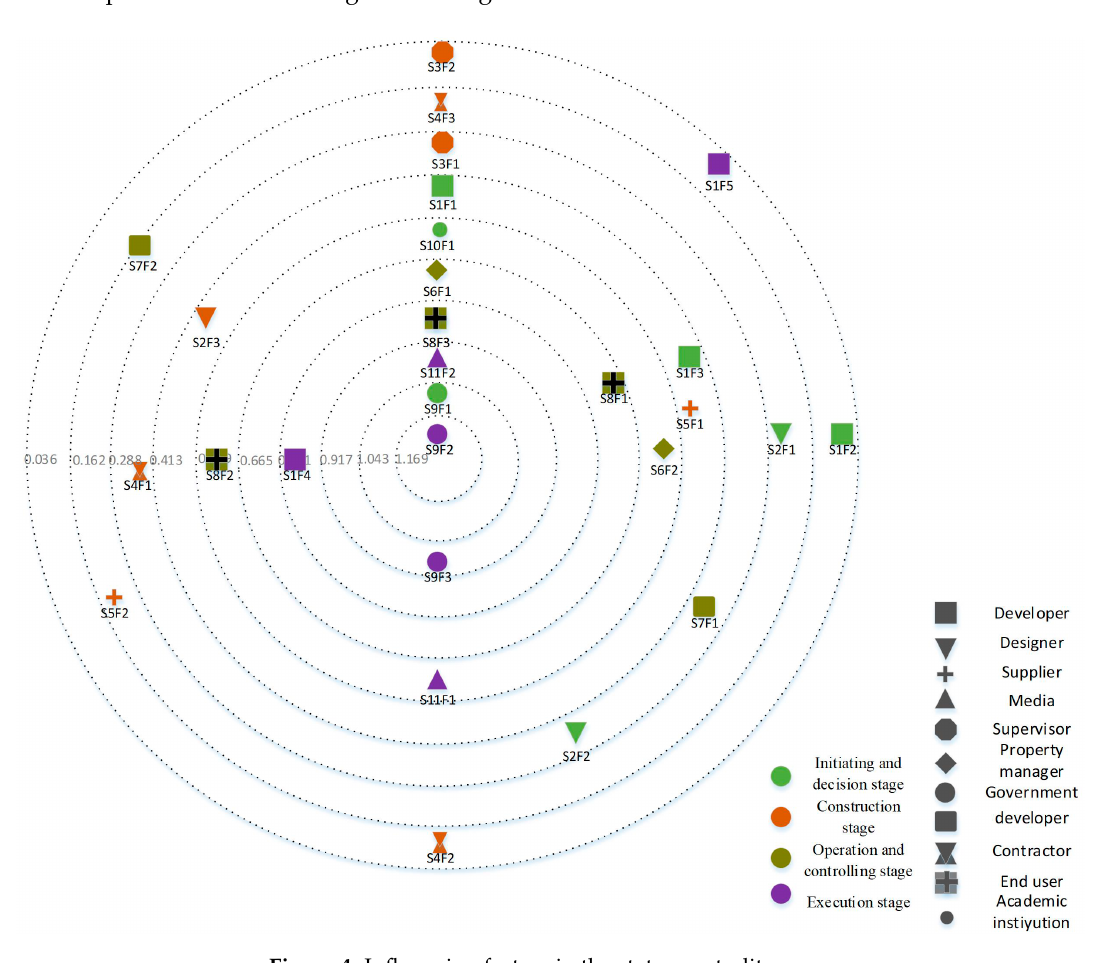
Figure 4. Influencing factors in the status centrality map.